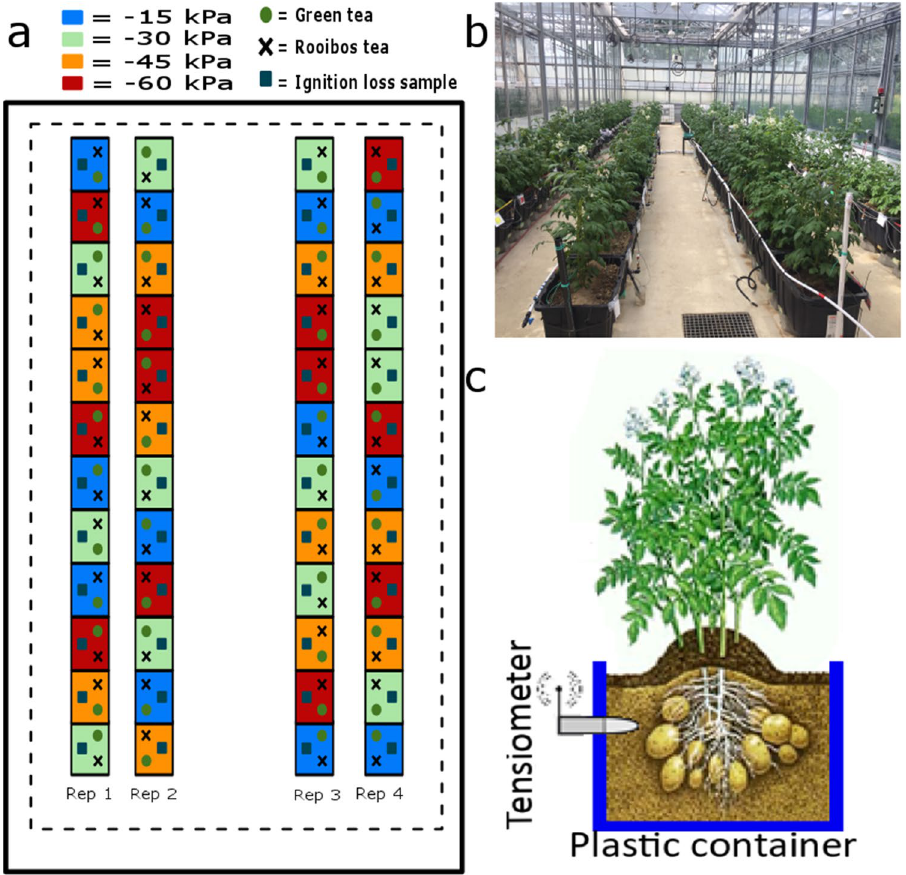
Figure 5. ( a ) Scheme of the experimental design in winter 2018 in the greenhouse, including four precision irrigation thresholds ( − 15, − 30, − 45 , and − 60 kPa), two tea types, and weight loss-on-ignition samples aggregated in 48 experimental units. ( b ) Picture of the greenhouse experiment. ( c ) Scheme of the short side of an experimental unit with one tensiometer.